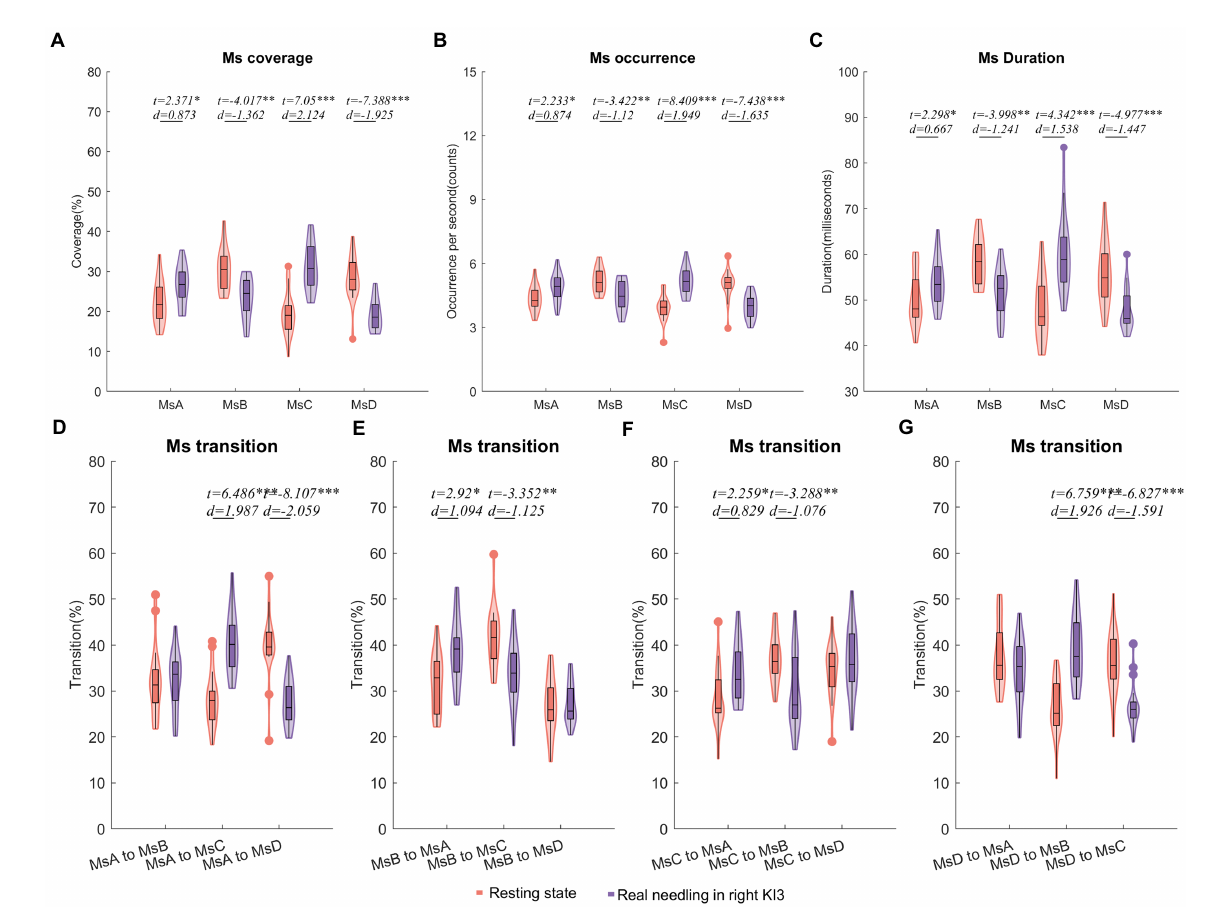
FIGURE 3 Temporal dynamics of EEG microstates in RA group. (A) The coverage of the four microstates in each condition within RA group. (B) The occurrence per second of the four microstates in RA group. (C) The duration of the four microstates in RA group. (D–G) Markov chain transition probabilities of the four microstates in RA group. Paired t -test with FDR correction * p < 0.05, ** p < 0.01, *** p < 0.001; The d values indicated the effect size (Cohen’s d ). Ms, microstate; RA, real